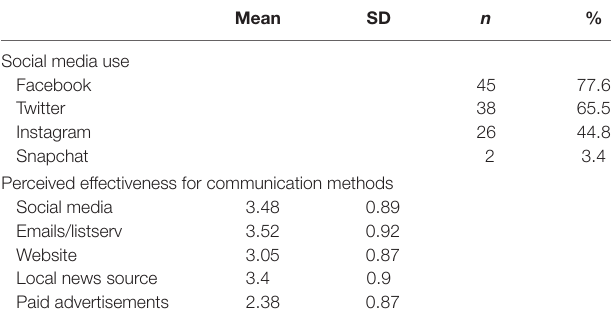
TaBle 4 | Coalition communication strategies ( n =